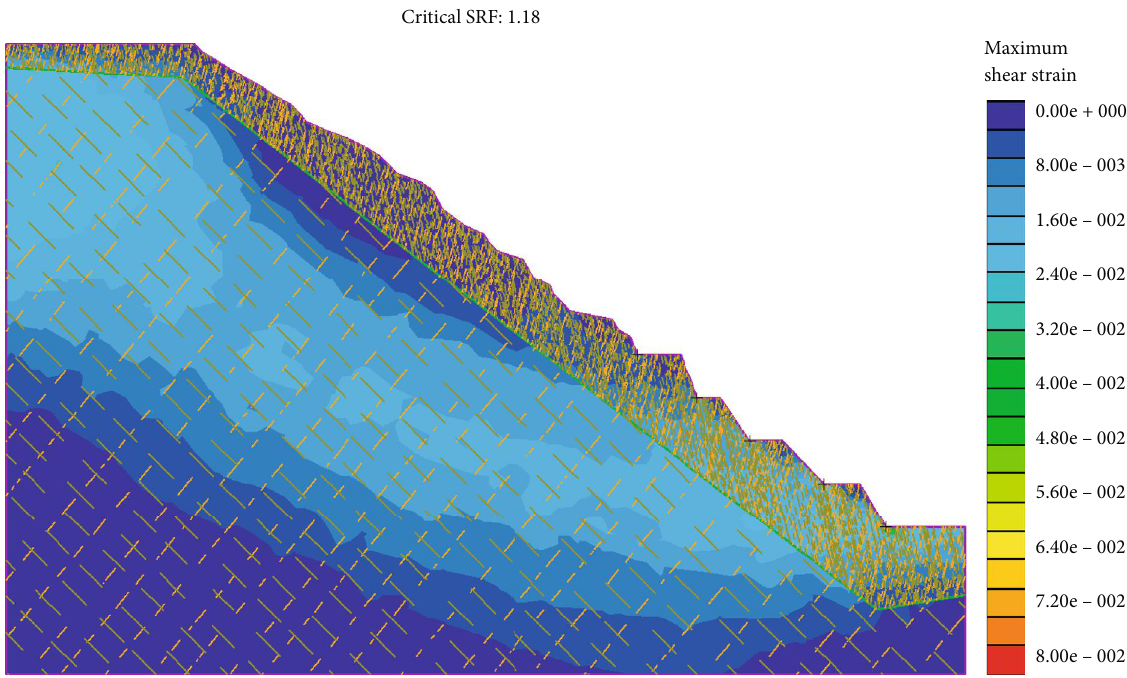
Figure 14: Cloud chart of maximum shear strain for di ff erent times of the freeze-thaw